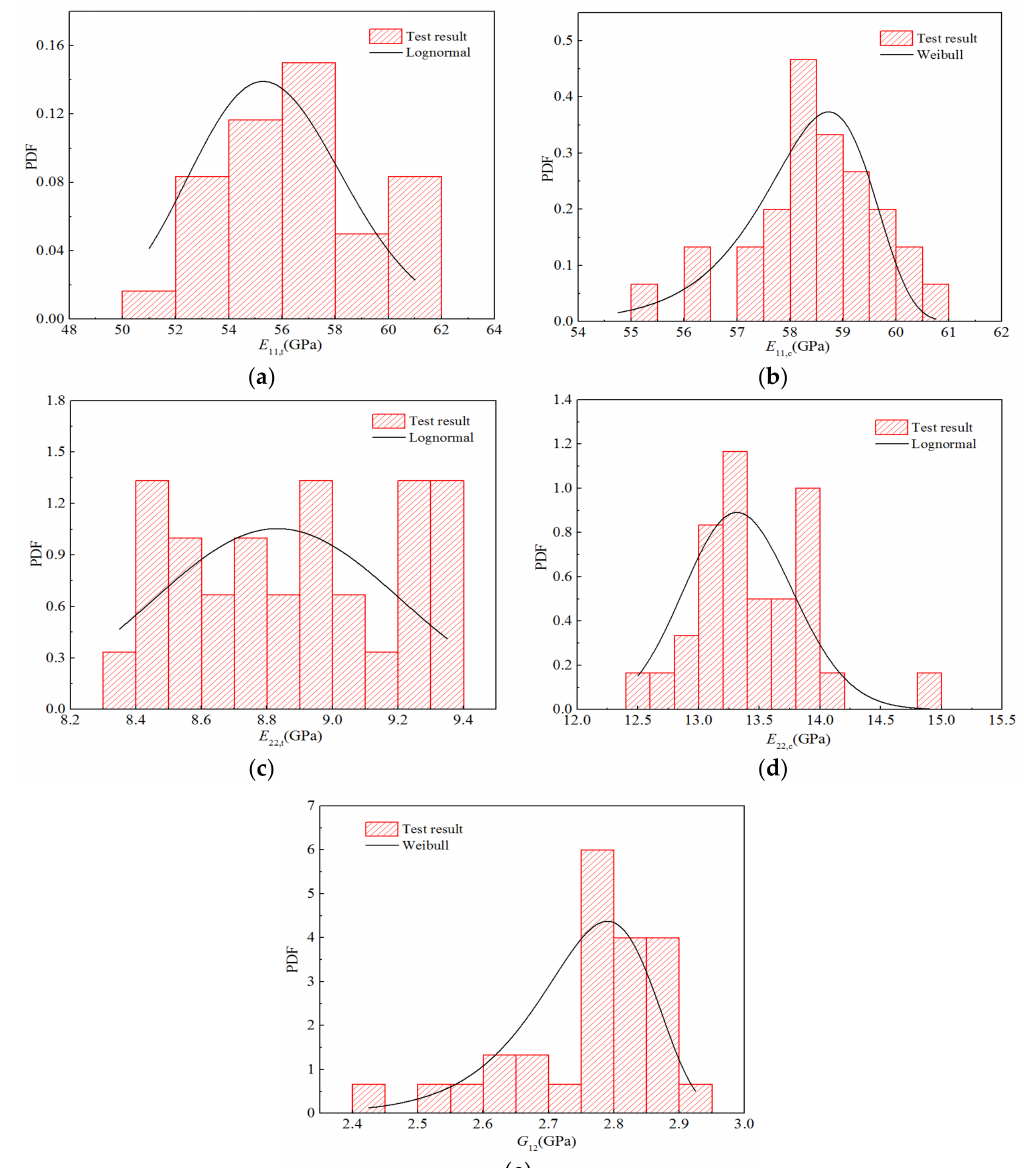
Figure 11. Probability distribution diagrams for the strength properties of H-GFRPs under the high- temperature equilibrium moisture absorption (ETW) condition. ( a ) E 11,t , ( b ) E 11,c, ( c ) E 22,t , ( d ) E 22,c, ( e ) G 12